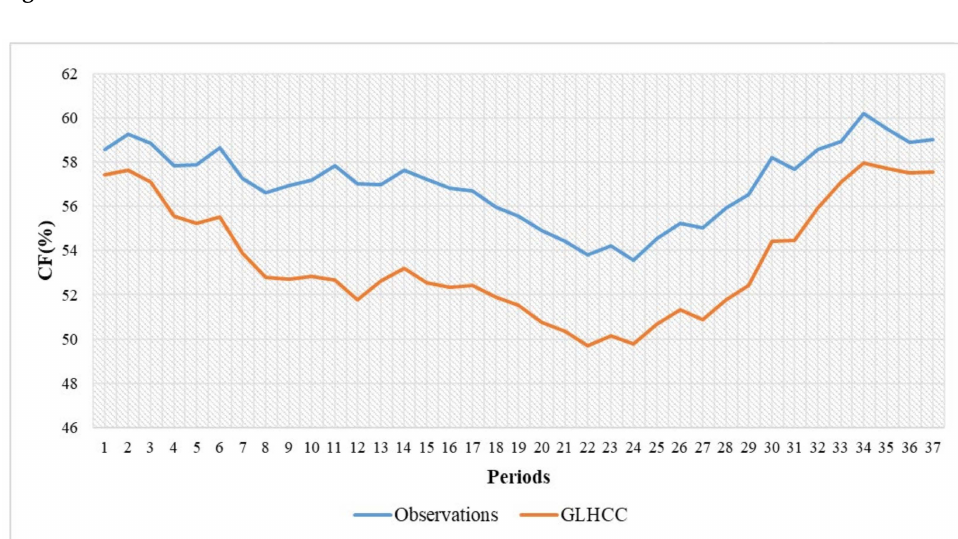
Figure 18. Global distribution of weather stations.